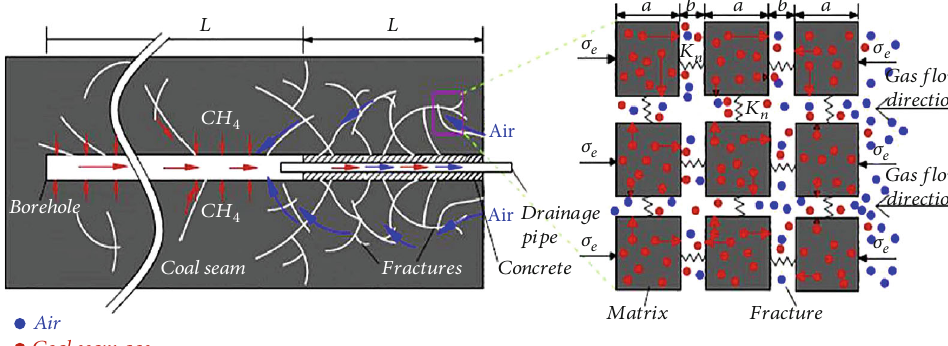
Figure 1: Schematic diagram of gas extraction leakage using in-seam boreholes [32, 33].